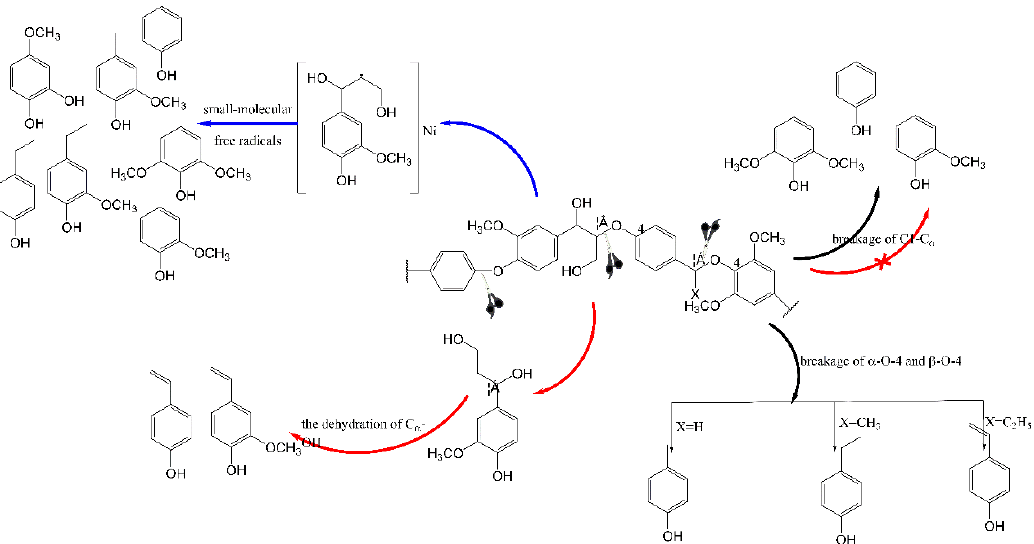
Figure 4. Proposed pathways of lignin pyrolysis (The black arrows represent pathways in “Water”; The blue arrows represent pathway in “Ni-washed”; The red arrows represent pathways in “Ni-unwashed”).